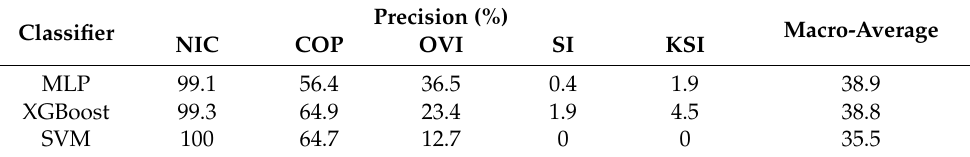
Table 2. Precisions of five-category classification problem.